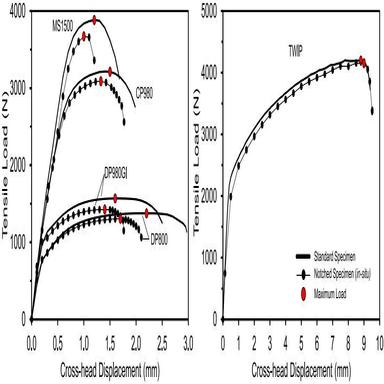
The tensile load vs. cross-head displacement for the Standard and Notched specimen tensile tests. The Notched specimen in-situ test data points represent the increments where SEM micrographs were captured. The Standard specimen curves are a single repeat test.